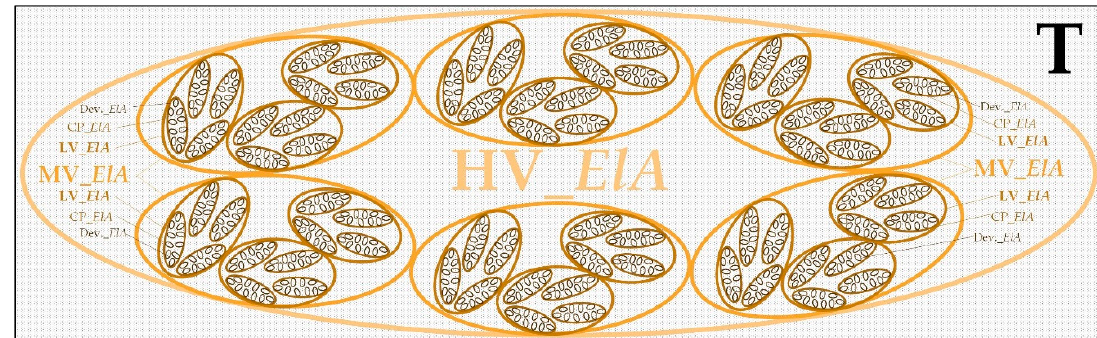
Figure 8. The fractal set of smart grids.